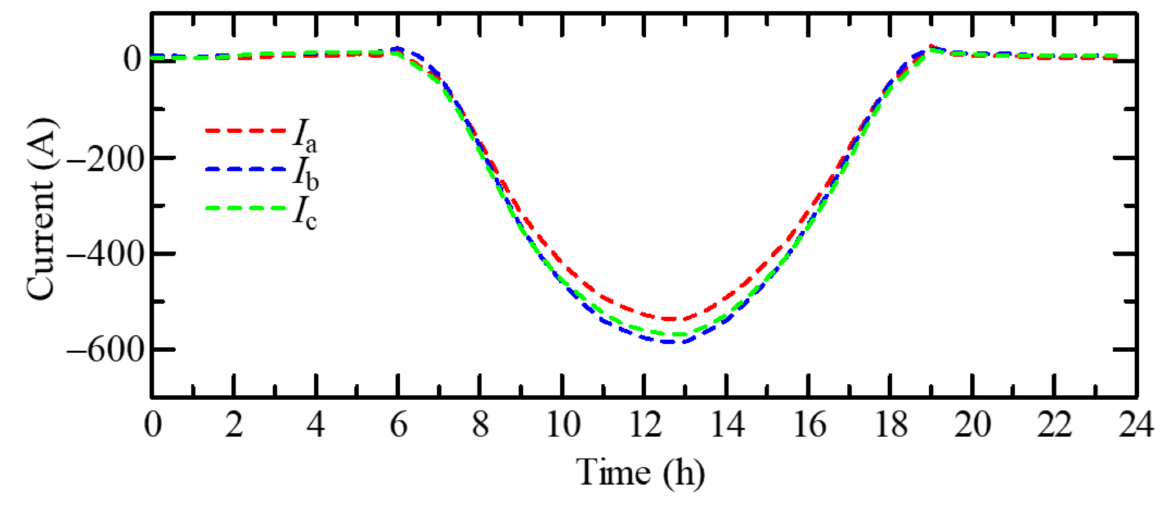
Figure 2. Time variation in the measured current in an actual distribution